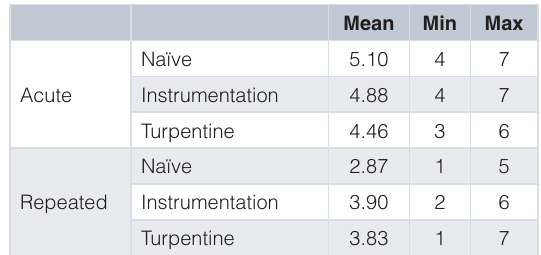
Table 2. Average number of sections analysed per animal during immunohistochemical analysis.